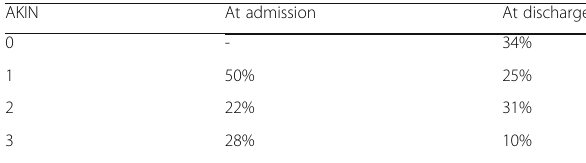
Table 1 (abstract 0420). AKIN of patients with